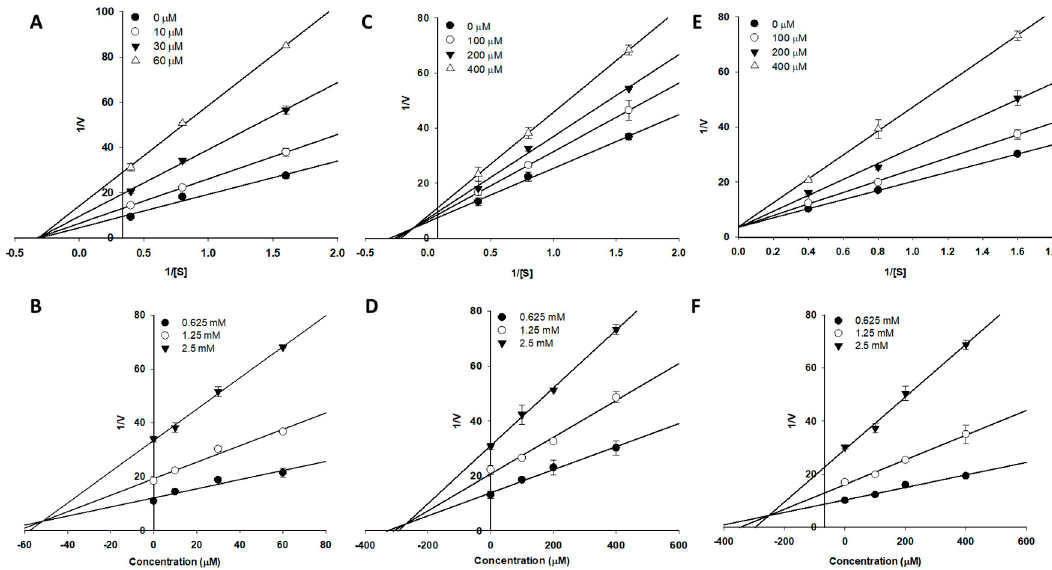
Figure 4. Lineweaver-Burk plot ( A , C , and E ) and Dixon plot ( B , D , and F ) for the inhibition of α -glucosidase by luteolin ( A and B ), luteolin 5- O - β - D -glucopyranoside ( C and D ), and luteolin 7- O - β - D -glucopyranoside ( E and F ), respectively.